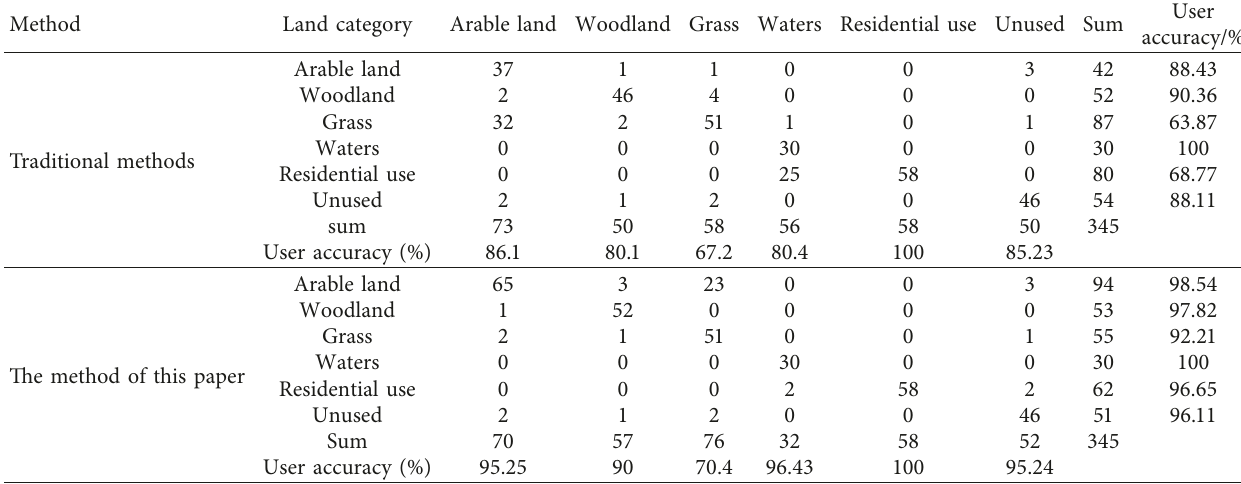
Table 3: Accuracy of land use classification by different